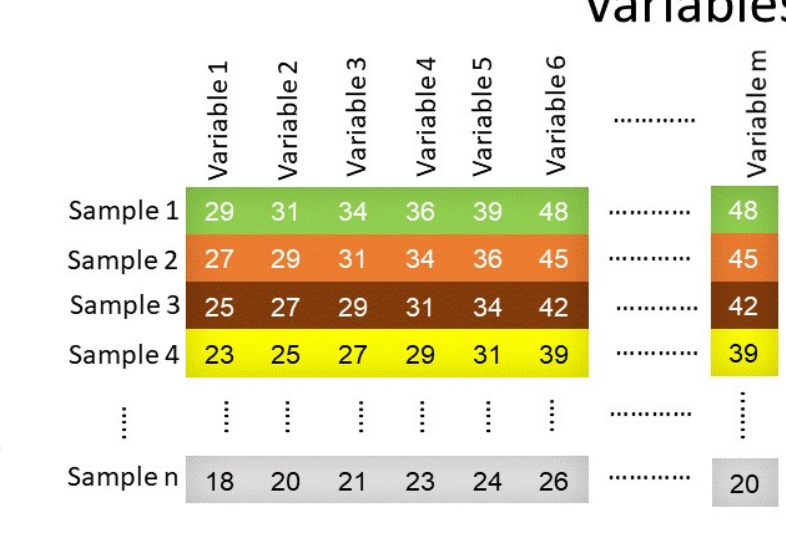
Figure 5. Representation of data in matrix form.